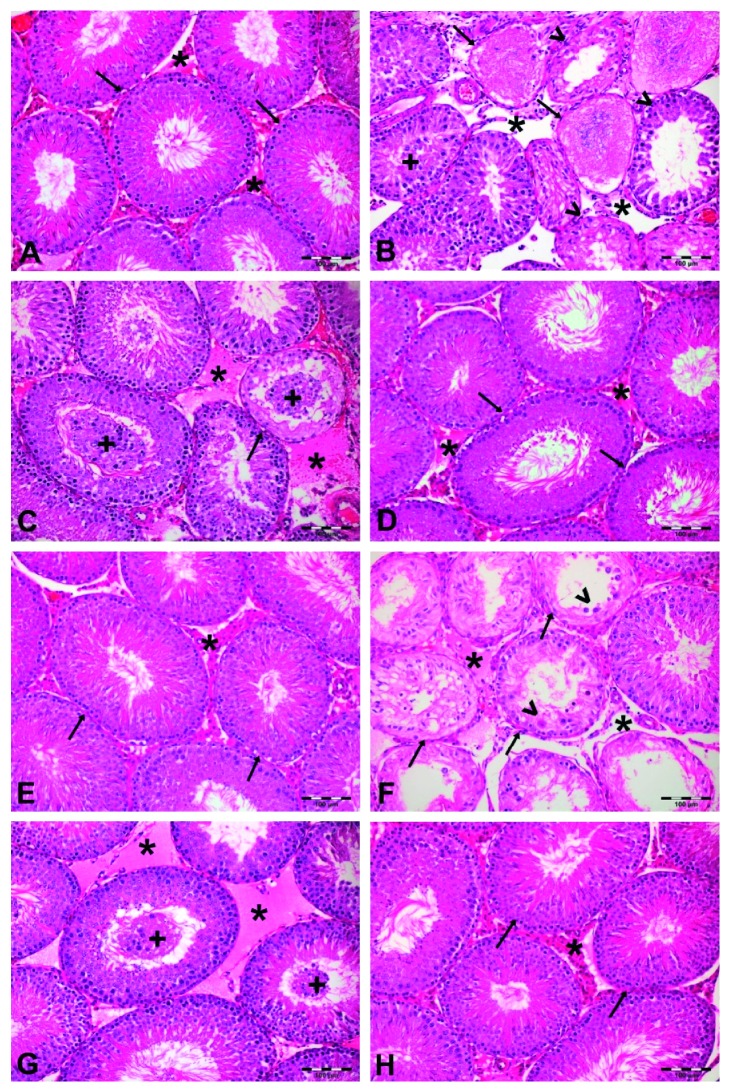
Light microscopic view of the testicular tissue samples of postnatal subjects (Group 1) and EDS-administered subjects (Group 2) (H&E). (a) Seminiferous tubules (arrows) and interstitial area (∗) were observed to be normal in control subjects of Group 1 (Group 1A). (b) Vacuolization (arrowheads) in the seminiferous tubule epithelium, immature cell accumulation (+) in the tubule lumen, empty seminiferous tubules (arrows), and interstitial edema (∗) were seen in GnRH-antagonist-administered subjects of Group 1 (Group 1B). (c) Vacuolization (arrows) in seminiferous tubules, immature cell accumulation (+) in the tubule lumen, and interstitial edema (∗) were seen to continue in GnRH-antagonist-and-osteocalcin-administered subjects of Group 1 (Group 1C). (d) Seminiferous tubules (arrows) and the interstitium (∗) were normal in only-osteocalcin-administered subjects of Group 1 (Group 1D). (e) In control subjects of Group 2 (Group 2A), the seminiferous tubules (arrows) and the interstitium (∗) were shown to be normal. (f) Vacuolization (arrows) and multinucleated giant spermatogenic cells (arrowheads) in the seminiferous tubule epithelium and interstitial edema (∗) were observed in GnRH-antagonist-administered subjects of Group 2 (Group 2B). (g) In GnRH-antagonist-and-osteocalcin-administered subjects of Group 2 (Group 2C), immature cell accumulation (+) and interstitial edema (∗) were seen to continue in some seminiferous tubule lumens. (h) Seminiferous tubules (arrows) and interstitium (∗) were observed as normal in only-osteocalcin-administered subjects of Group 2 (Group 2D). Bar = 100 μm.